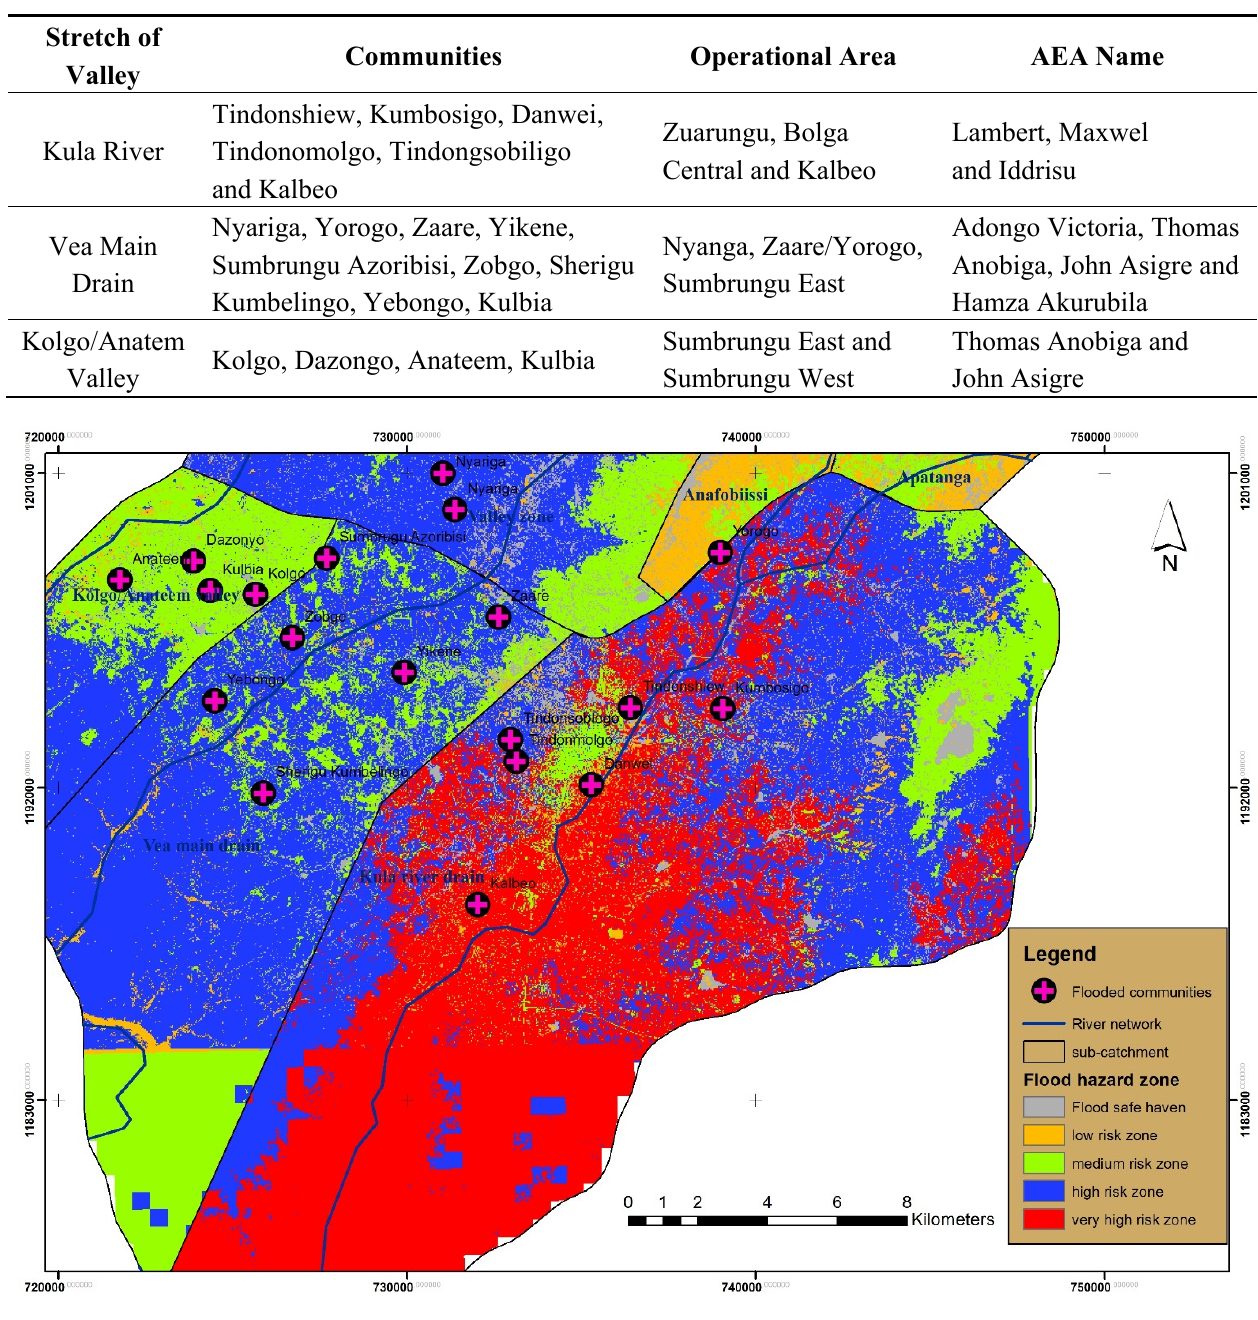
Figure 9. Qualitative validation of FHI with local expert